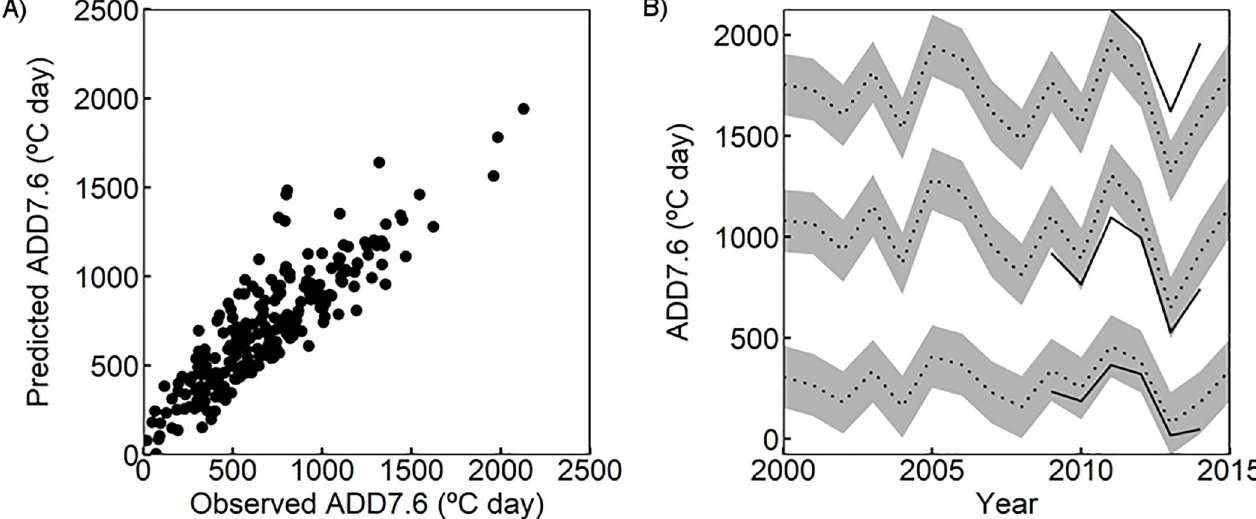
Fig 5. Predictions of ADD7.6 models. A) Predicted against observed ADD7.6. Predicted ADD7.6 are calculated from averaged predictions of the cross- validation (k = 5). B) Observed and predicted ADD7.6 (˚C day) for lakes Estanyet de Sotllo, Llebreta and Estanho de Vilac (from colder to warmer). Observed values are depicted with continuous lines, while predicted values are drawn with dotted lines. Standard deviations to the predicted values are represented by grey ribbons.